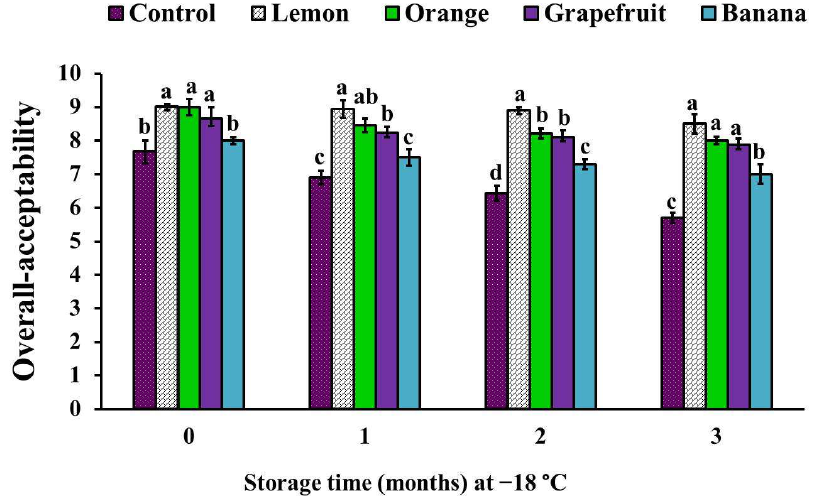
Figure 4. Overall acceptability scores of chicken patties with the incorporation of different fruit peel powders. Columns marked by different letters means significant differences ( p < 0.05).